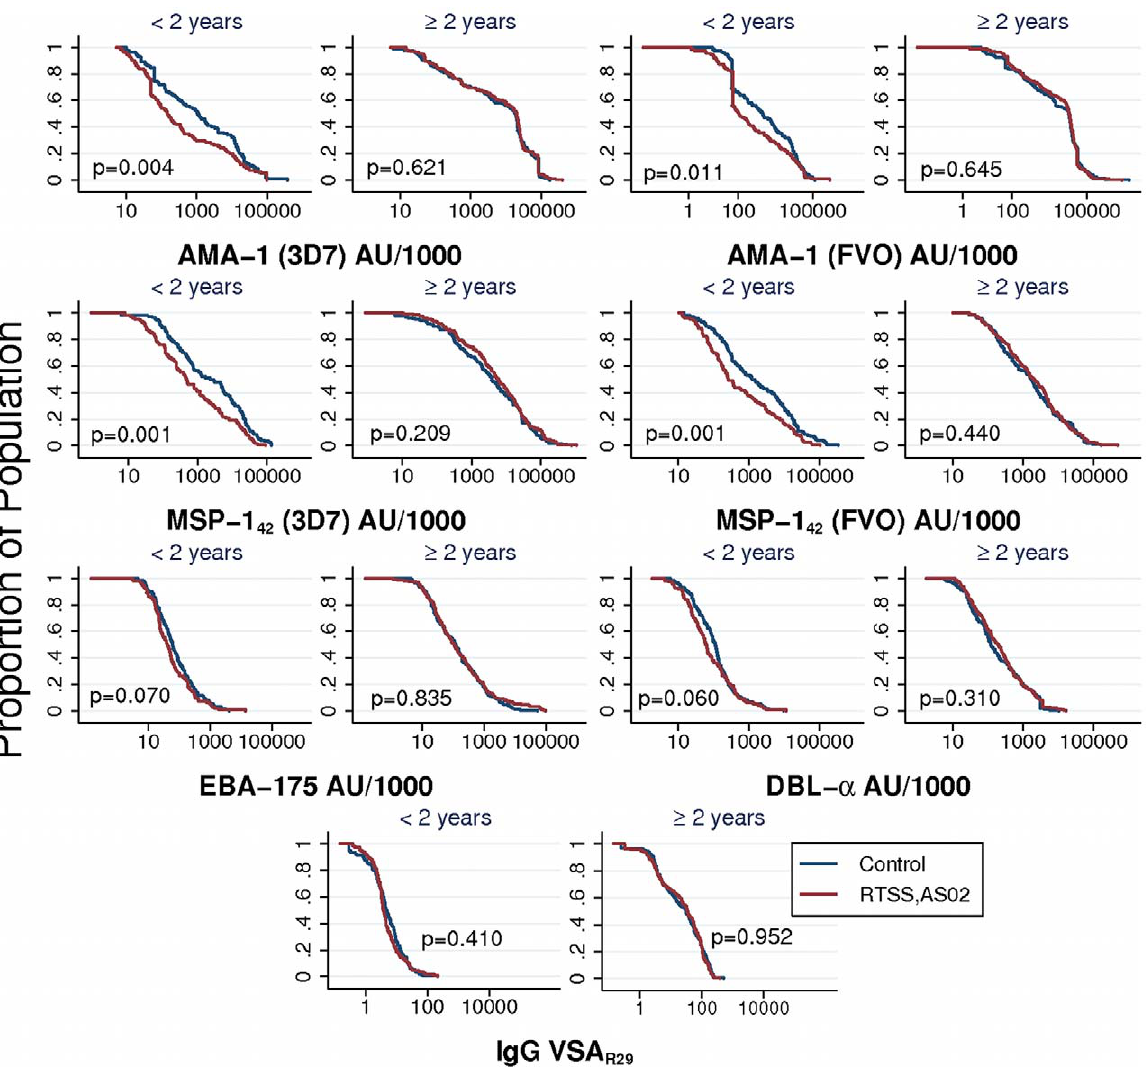
Figure 2. Reverse cumulative distribution of antibodies in RTS,S/AS02 vaccine vs. control vaccine groups, stratified by age group. The graphs represent the pooled antibody responses (cohorts 1 & 2) who received RTS,S/AS02 vaccine or control vaccine.